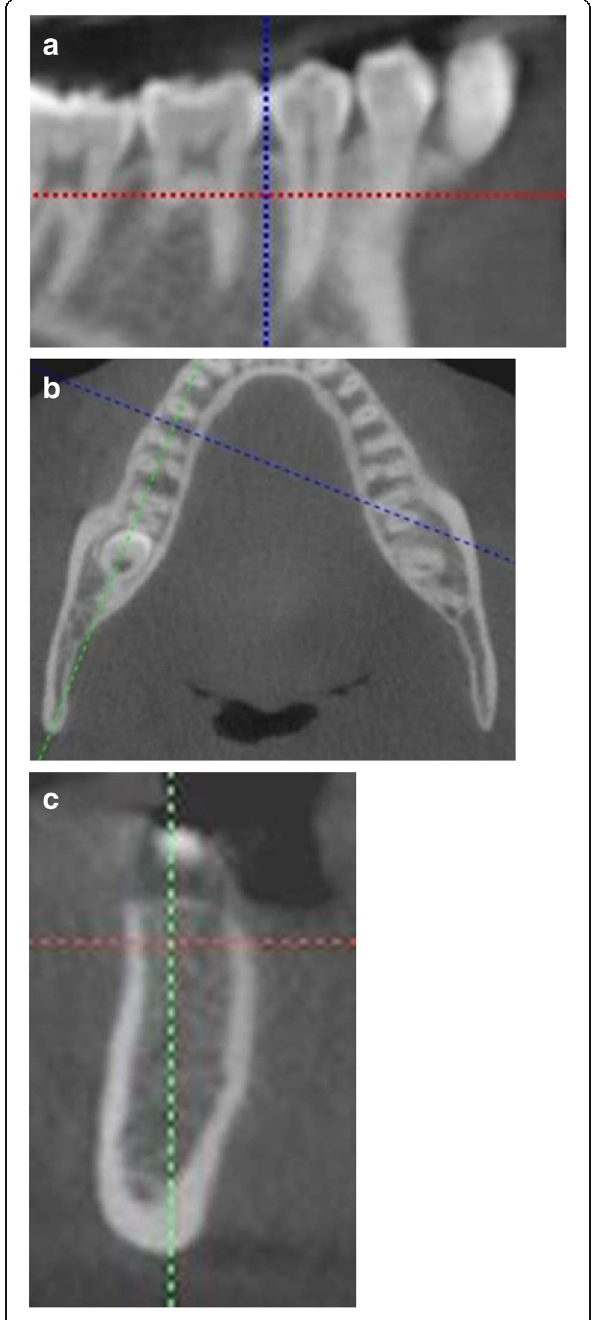
Fig. 2 Orientation of views for the inter-radicular measurements.